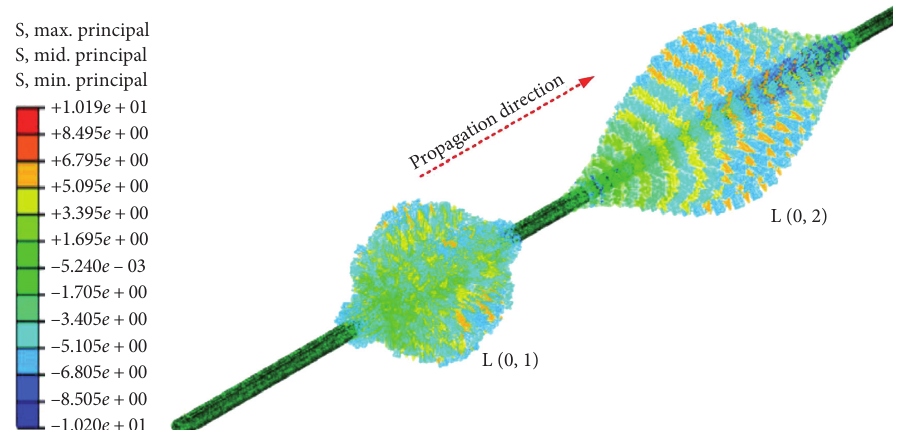
Figure 8: Symbol chart of all the principal components of